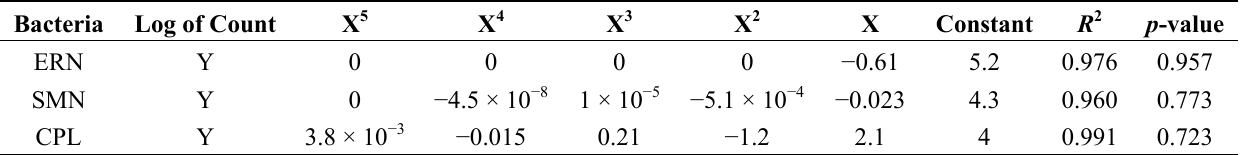
Table 1. Regression model of log bacterial count with retention time